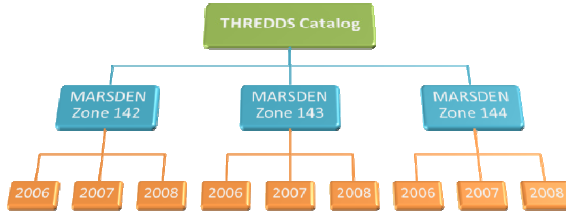
Table 2. THREDDS elements mapping onto GI-cat